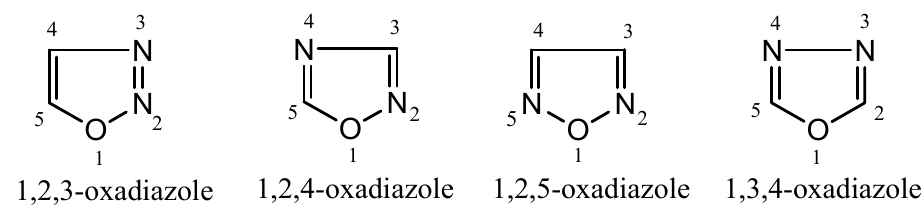
Figure 2. Chemical structures of oxadiazole isomers.